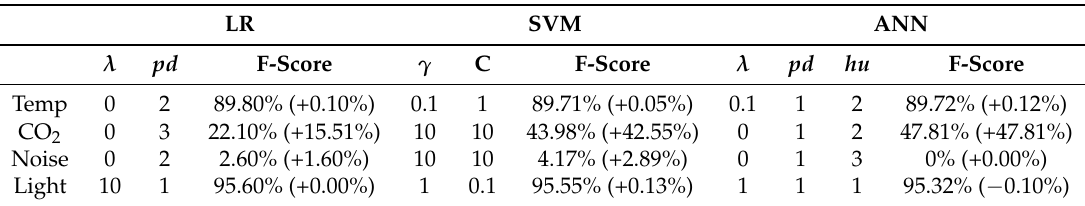
Table 4. F-Score results of parameters that perform the highest score for LR, SVM, and ANN for the binary problem. LR